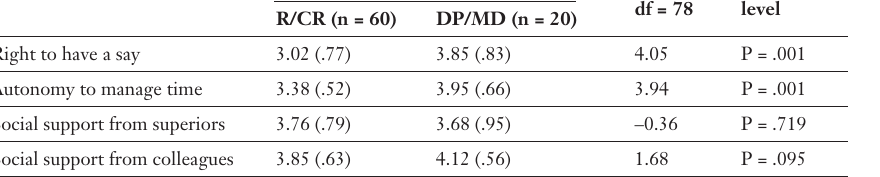
Comparison of means between R/CR and DP/MD for “external resources